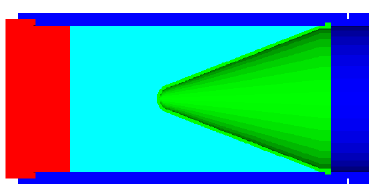
Fig. 2. Numerical model of SC.